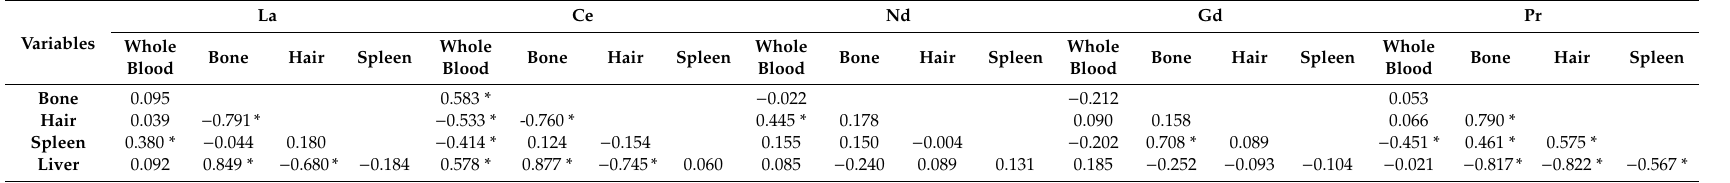
Table 3. The correlations of REE concentrations among di ff erent tissues and organs of